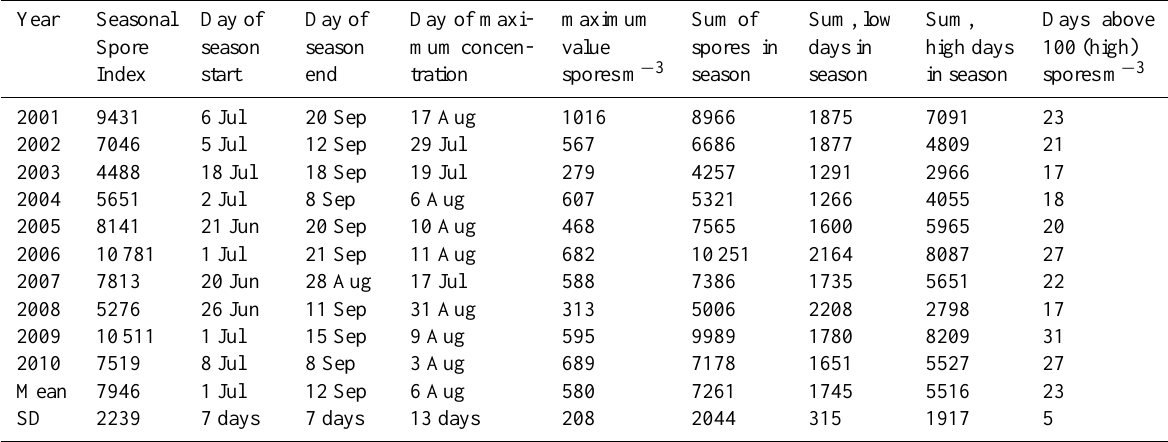
Table 1. Seasonal spore index, day of season start, day of season end, and day of maximum spore concentration and its value. Sum of spores during season, sum on low days and sum on high days and number of days above the critical threshold of 100 spores as a daily mean value. The sum of low days and high days correspond to the total accumulated catch during the season (the days that cover 95% of the entire catch) and not the entire year.